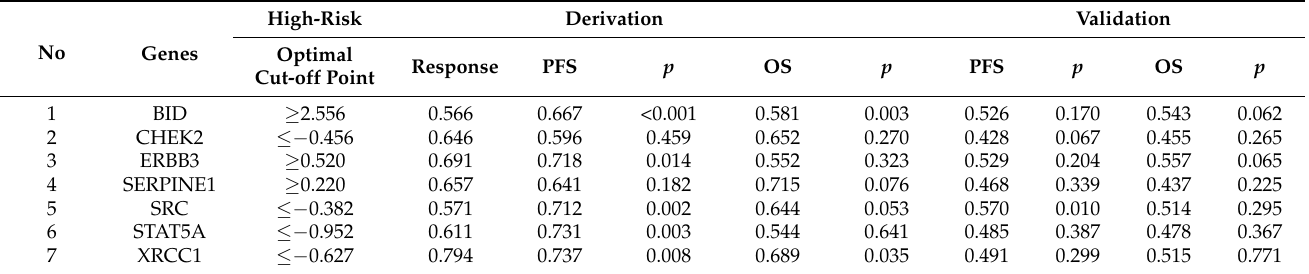
Table 5. The results of optimal cut-off point and individual ROC analysis in seven targets from RPPA.